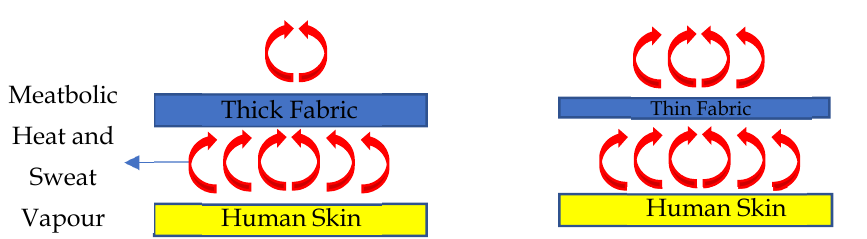
Figure 6. Heat transfer through thick and thin fabrics for THL.